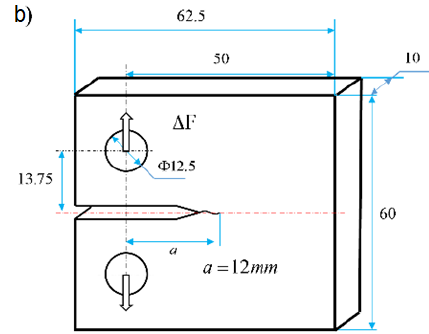
Figure 11. Processing and fatigue test of round bar and CT specimens (units, mm). ( a ) the dimensions of the round bar specimen. ( b ) the dimensions of the CT specimen [54]. Table 3. Strain fatigue test results [54].